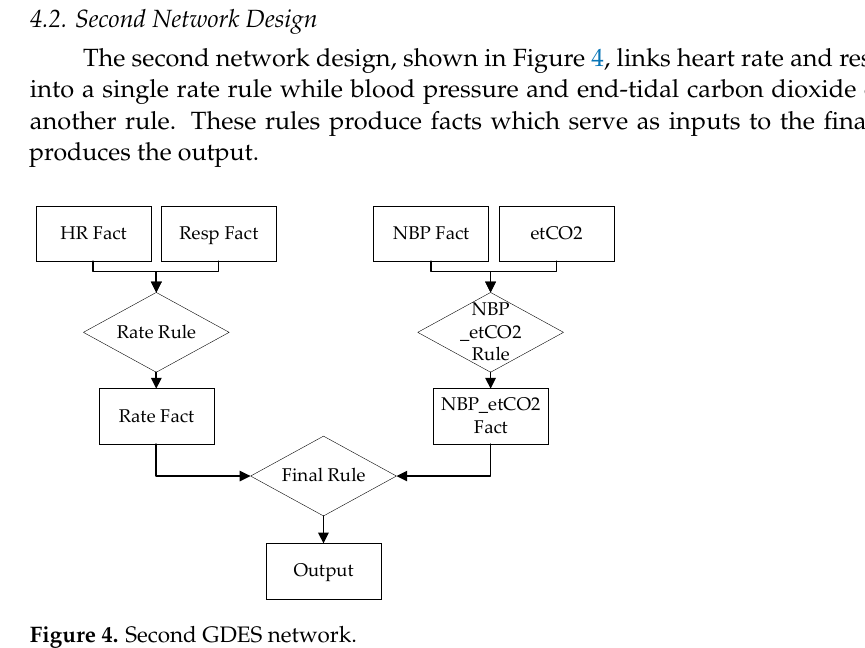
7 Table 5 represents the lowest performing collection of trials that utilize the second GDES network model. This is trials 11 through 20, indicating the use of the isolated data conversion method. The third PR approach described in Section 3.2 is used. In trials 11, 13, 14, 17, 18, and 19 the target patient deviated from the target value more than the aver- age of all patients. No patients, correct or incorrect, fall within any listed margin of error.